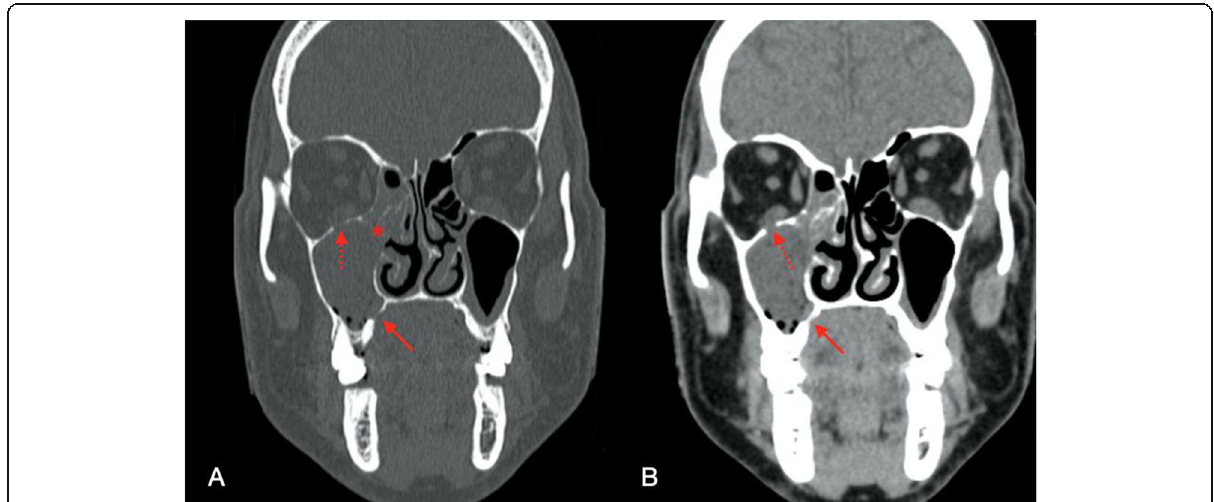
Fig. 5 Coronal bone ( A ) and soft tissue ( B ) window demonstrating the mucosal thickening in right ethmoidal and bilateral maxillary sinuses (right > left) with collection in right maxillary sinus. A small defect is noted in postero-lateral and inferomedial maxillary wall on right side (arrow) with minimal soft tissue thickening is noted in right orbit abutting inferior rectus muscle (dashed arrow) with a blocked OMU (asterisk)